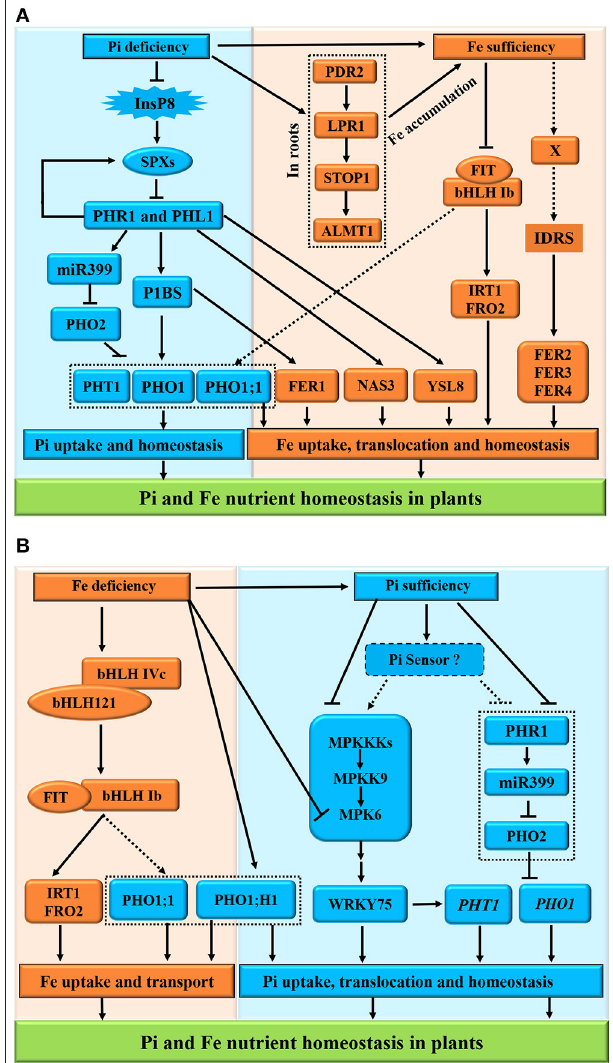
FIGURE 4 | Schematic representation of Pi and Fe homeostasis interactions in plants. The phosphate (Pi) deficiency promotes the iron (Fe) accumulation (A) ; conversely, Fe deficiency induces the high Pi in plants at the physiological level (B) . For the molecular bases of the Pi-Fe cross-talk, the PHR1, PHL1, PHO1;1, PHO1; H1, FER1, STOP1, and MPK6 act as potential integrators of Pi and Fe nutrient signals in plants. (A) Under Pi deficiency, the PHR1 and PHL1 function as the core transcription factors controlling the expression of Pi transporters PHT1 and PHO1 via the PHR1-miR399-PHO2-signaling pathway. Moreover, PHR1 and PHL1 act as the positive regulators of the transcription of Fe transporters FER1, NAS3, and YLS8 responsible for Fe homeostasis in plants. On the other hand, Pi deficiency also induces the STOP1-modulated signaling to promote Fe accumulation in roots. However, under Fe sufficiency, as a key cis -acting element of plant iron homeostasis, IDRS (iron-dependent regulatory sequence, which is bound by unknown factor X) is responsible for the upregulation of ferritin genes FER2 , FER3 , and FER4 , whereas the central regulator FIT is inactivated to inhibit the expression of FRO2 and IRT1 . (B) By contrast, Fe deficiency activates the interacting bHLH IVc (bHLH34/104/105/115) and bHLH121 complex to positively regulate the expression of bHLH Ib (bHLH38/39/100/101) and FIT. The bHLH Ib and FIT interact with each other to induce the expression of Fe uptake-related